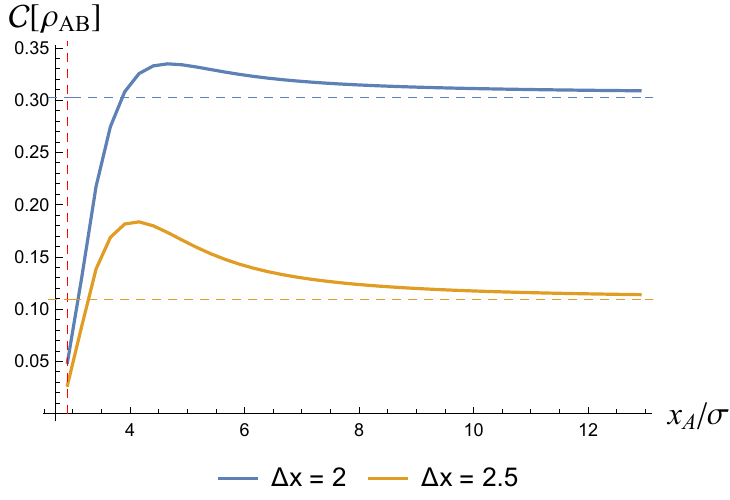
Figure 1 . Replacement for the left (cid:12)gure of (cid:12)gure 5. Open